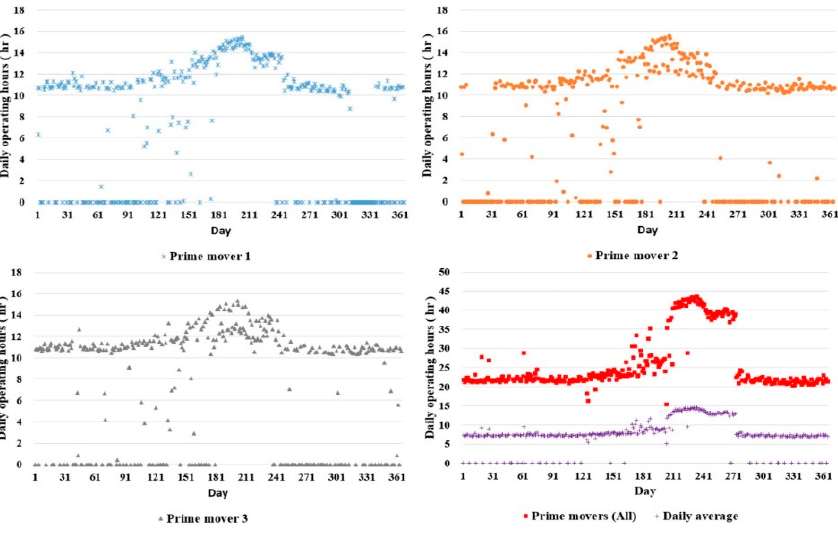
Figure 4. Annual daily operation hours of prime movers for Case A.